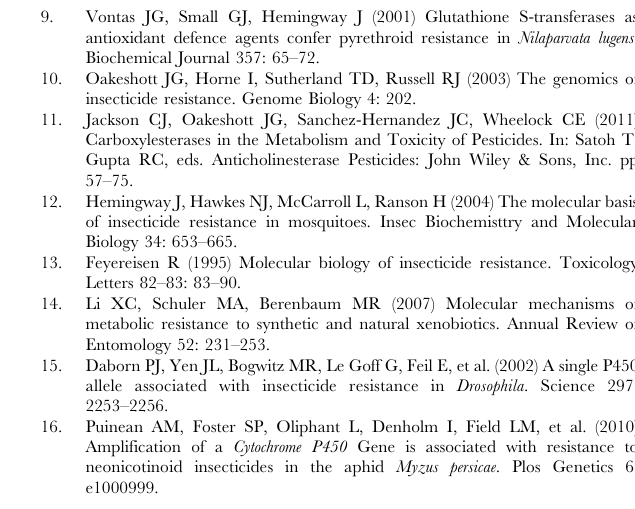
Table S1 The full list of up-regulated genes, with the